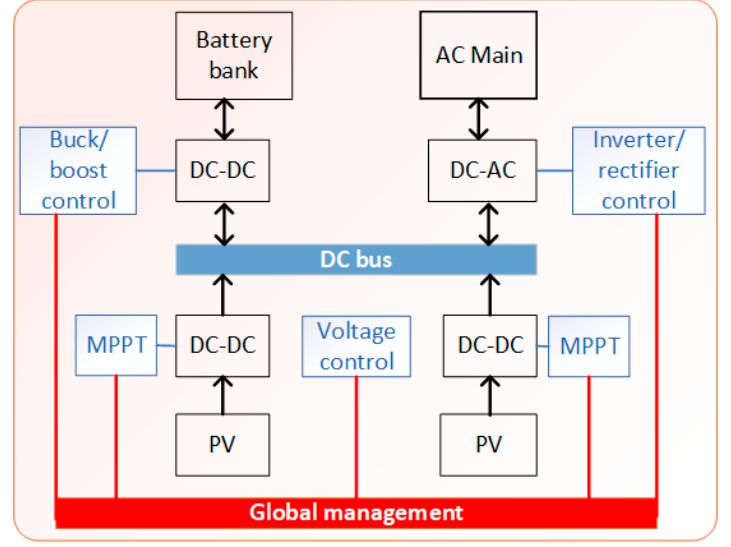
Figure 6. General block system.